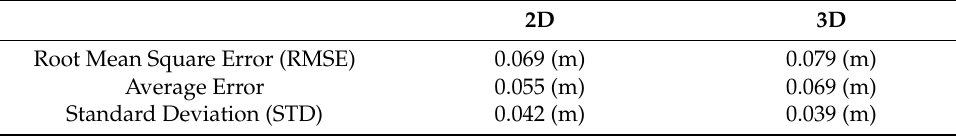
Table 5. Results achieved from modeling roads in OpenDRIVE format.